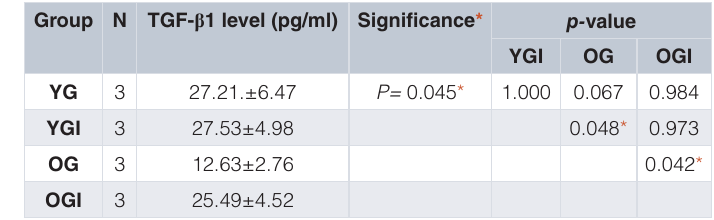
Table 4. Descriptive statistics and results of the Anova and Tukey HSD tests comparing the TGF- β 1 in the 4 groups tested at day 21 after orthodontic appliance installation.